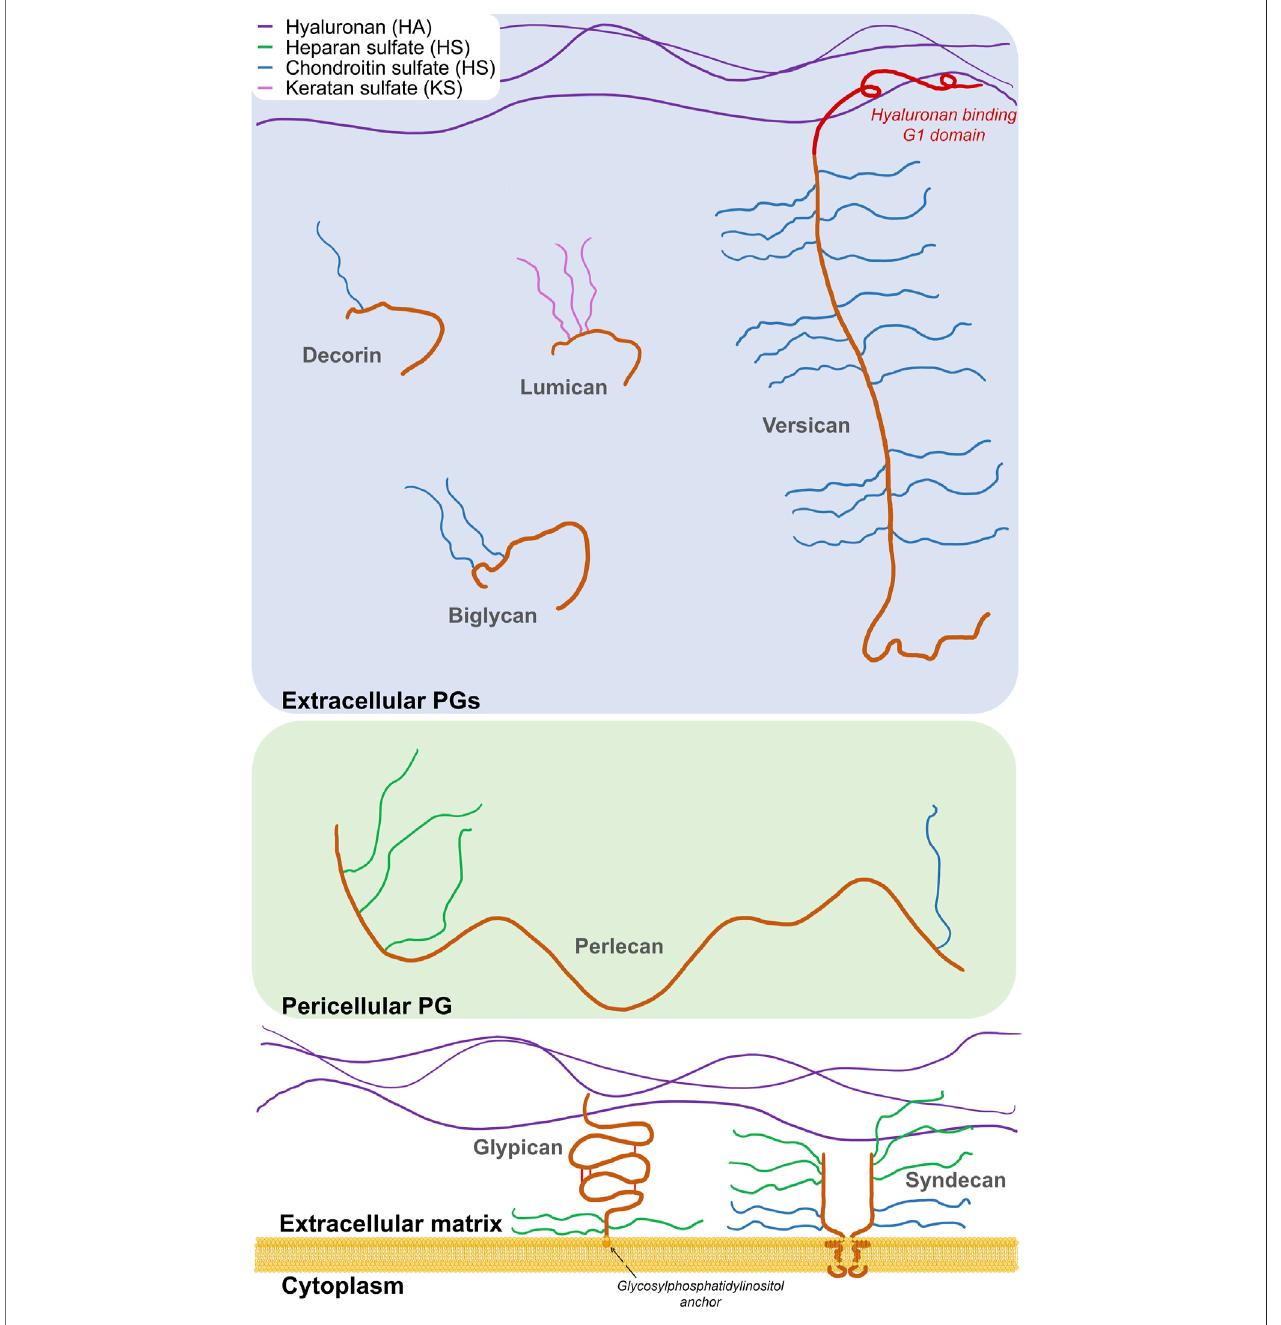
FIGURE 2 | Schematic representation of the main vascular PGs according to their localization. Three main classes are reported: cell-associated, pericellular, and extracellular proteoglycans. Protein moieties are shown as orange backbones (versican G1 domain is highlighted in red).